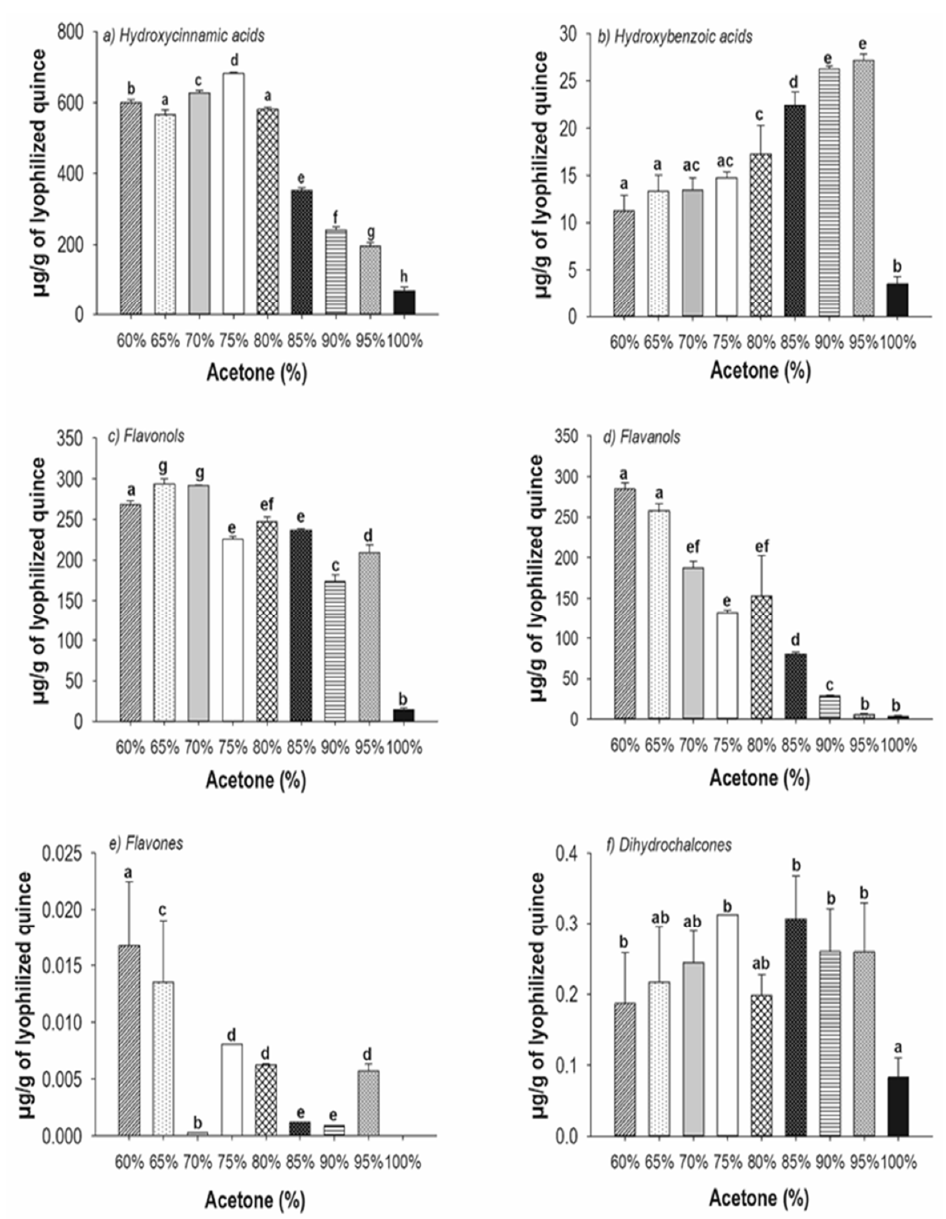
Figure 3. Effect of aqueous acetone on the extraction of polyphenolic compounds in Quince fruit ( Cydonia oblonga Mill.). Different letters indicate statistical significance (ANOVA, Tukey p < 0.001).